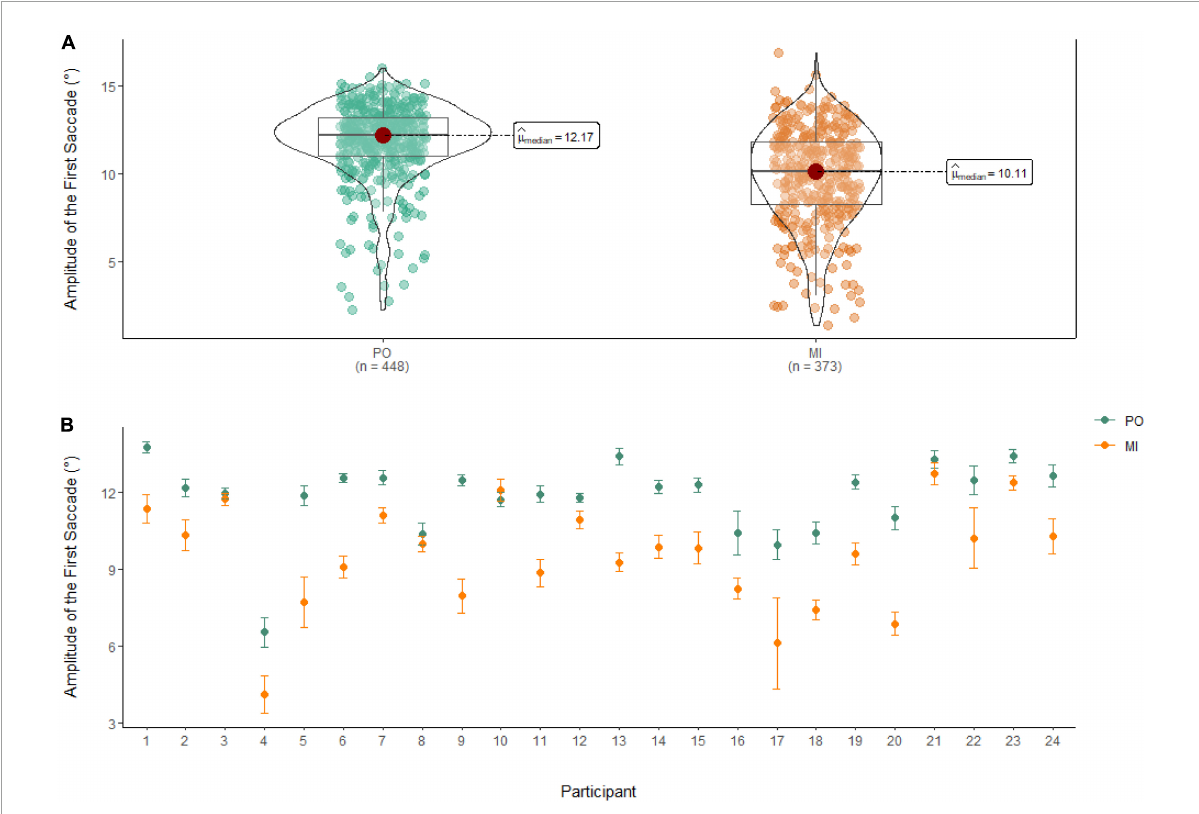
FIGURE7 (A) Differences in the amplitude of the first saccade between PO (left) and MI (right). (B) The average amplitude of the first saccade for PO (blue) and MI (orange) is displayed for each of the 24 participants enrolled in the experiment. Error bars are standard error of the